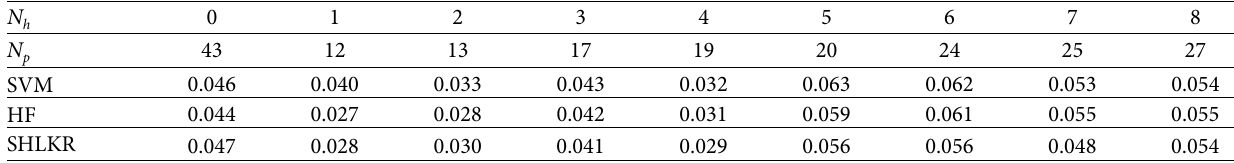
Table 3: RE comparison using different number of historical records.